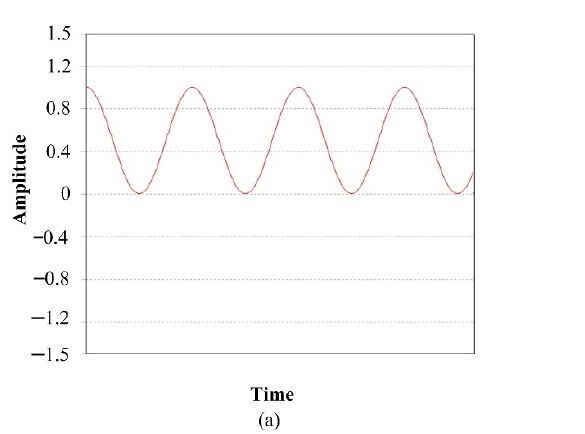
Figure 6. Characteristics of a fatigue analysis: ( a ) zero-based loading and ( b ) mean stress correction theory (Goodman, Soderberg, and